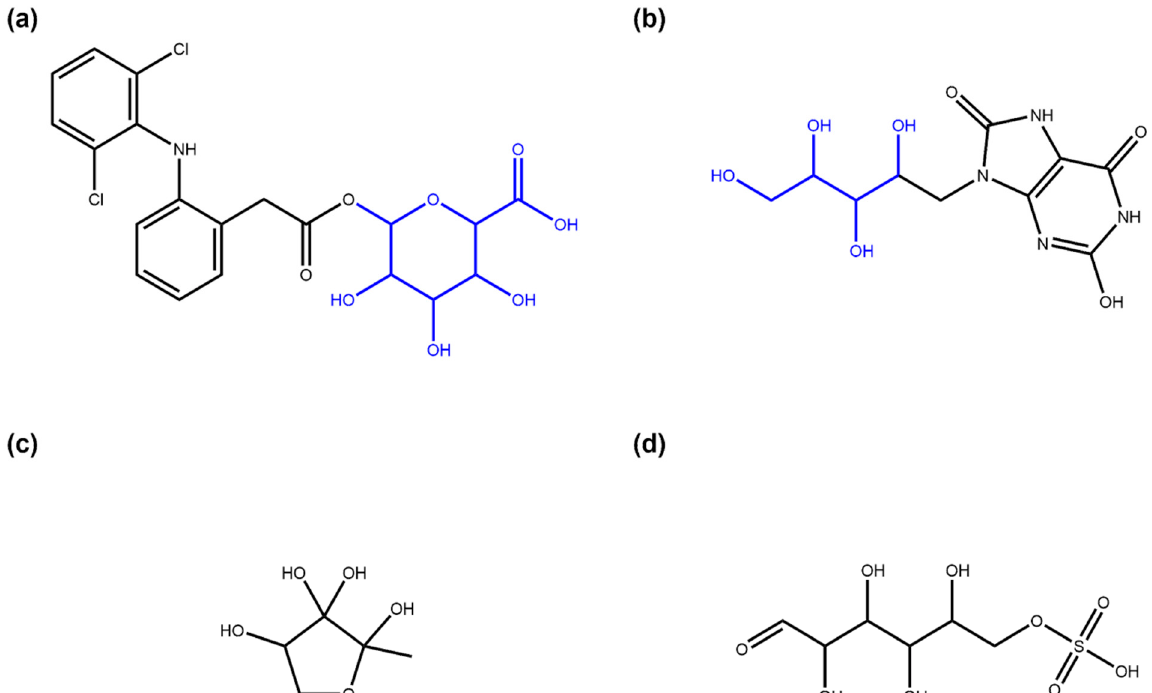
Figure 17. Examples of glycosidic molecules in ZINC “for sale” and “in vitro” subsets. ( a ) Diclofenac acyl glucuronide (ZINC ID ZINC35048352, part of the “for sale” and “in vitro” subsets), a metabolite of diclofenac that is suspected to mediate toxic side-effects of this drug [32]. The SRU detects the glucuronic acid moiety (in blue) added in metabolisation as a terminal circular sugar moiety. ( b ) 9-D-ribityl-1,3,7-trihydro-2,6,8-purinetrione (ZINC58650741, part of the “in vitro” subset), a uric acid derivative with a D-ribityl moiety (in blue, identified by the SRU) that can be used as a mimic of uridine diphosphate to inhibit human blood group B galactosyltransferase [33]. ( c ) (2R, 4S)-2-methyl-2,3,3,4-tetrahydroxytetrahydrofuran (ZINC6491067, part of the “for sale” and “in vitro” subsets) is not annotated in ZINC as NPs or metabolite and is also not part of COCONUT, although it has been identified as an autoinducer, a molecule used by bacteria for intercellular communication [34]. The SRU detects this structure as a circular monosaccharide. ( d ) D-glucose 6-sulfate (ZINC5132028, part of the “in vitro” subset), a sulfate analogue to the general metabolite D-glucose 6-phosphate in the open-chain form that is listed in ZINC as being found active in in vitro binding assays. The structure is recognised by the SRU as a linear monosaccharide.